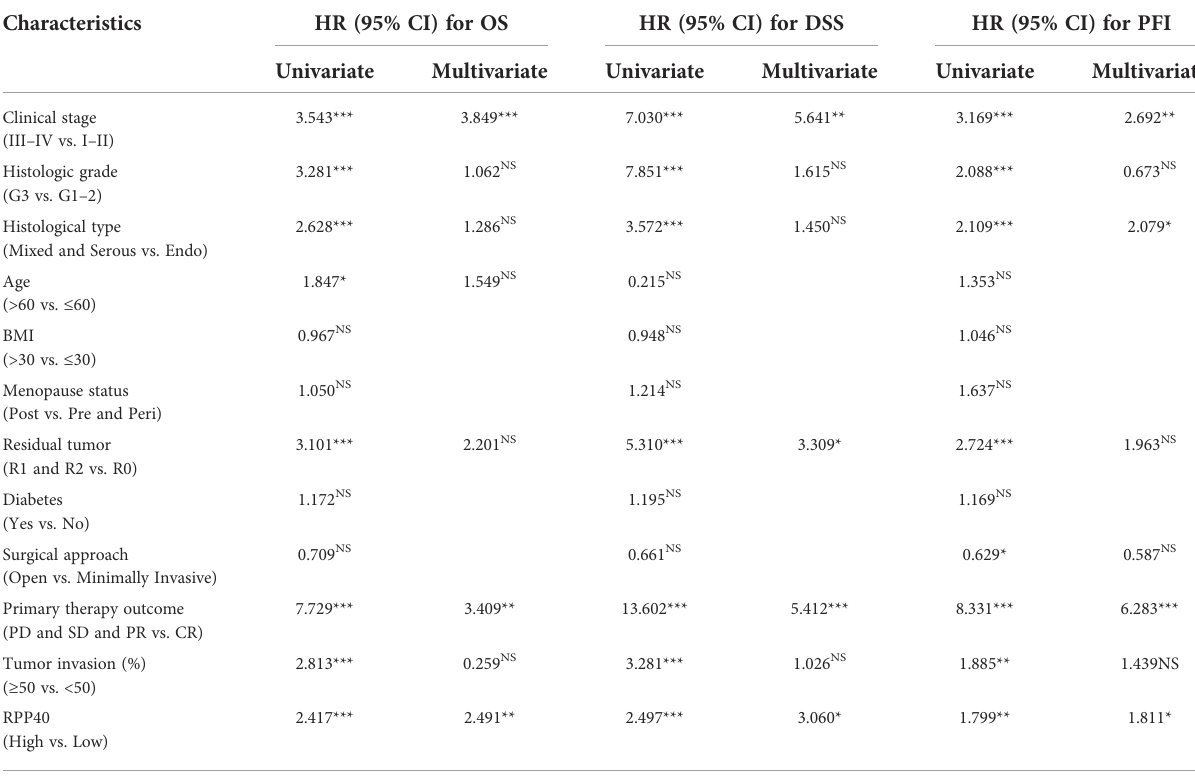
TABLE 3 Cox regression analysis for clinical outcomes in UCEC